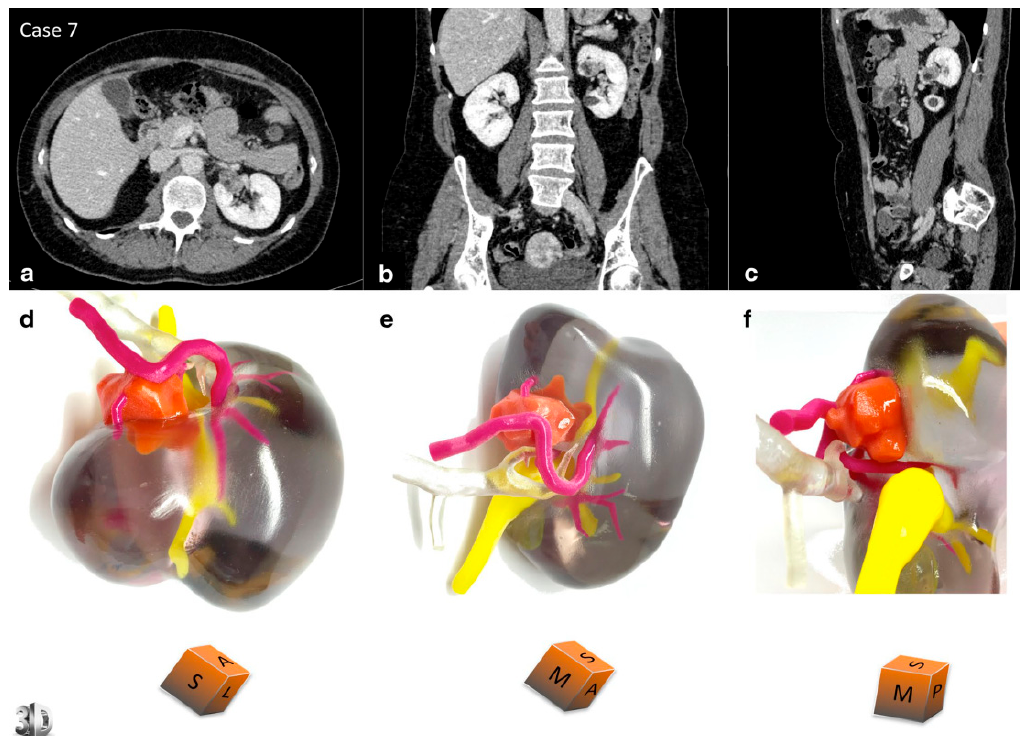
Figure 5. 3D-printed model of a 53-year-old female with a renal tumour at the interpolar region of left kidney. Comparative views of the CT scan at the nephrographic phase (( a ) axial, ( b ) coronal, and ( c ) sagittal planes) and corresponding views of the physical model (( d ) superior view, ( e ) median view, and ( f ) median view). The cubes show the 3D-printed model orientation in space (I = inferior face, A = anterior face, L = lateral side, S = superior face, P = posterior face, M = median side). The patient underwent a left partial nephrectomy for a 21 × 15 × 15 mm angiomyolipoma. Description of colour corresponding to different renal structures and tumour is the same as in Figure 4. Reprinted with permission from Bernhard et al. [6].